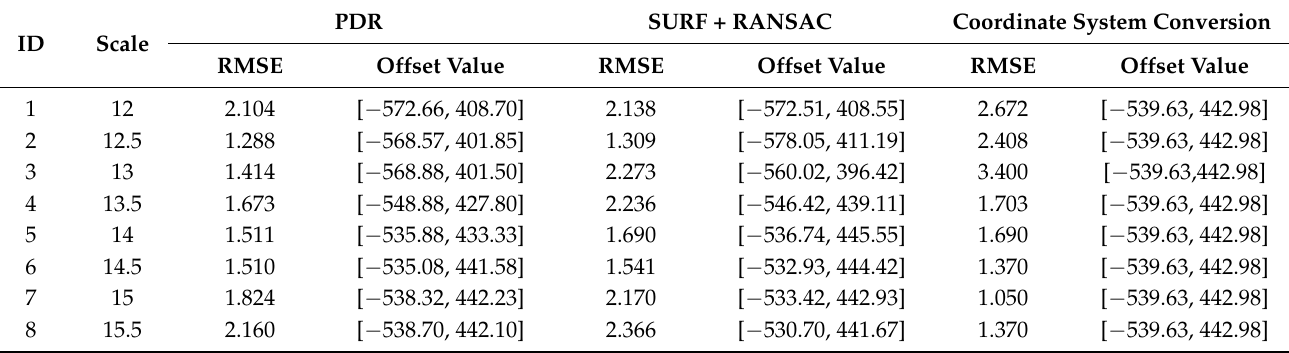
Table 3. Registration results of three methods in remote sensing maps of